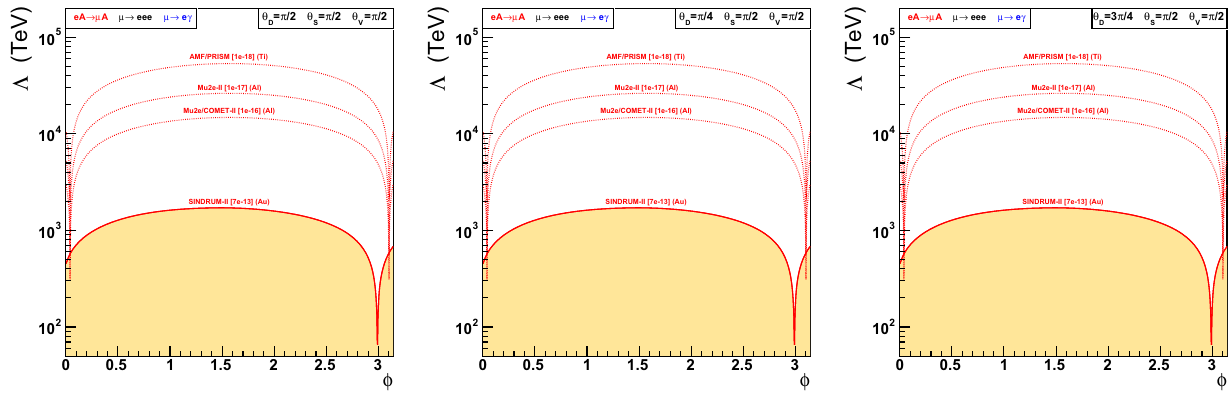
Fig. 3 Reach as a function of the angle φ for different contributions of the dipole operator: (left) θ D = π/ 2, (middle) θ D = π/ 4, and (right) θ = 3 π/ 4. Note that φ runs from 0 → 2 π , although it is plotted from D